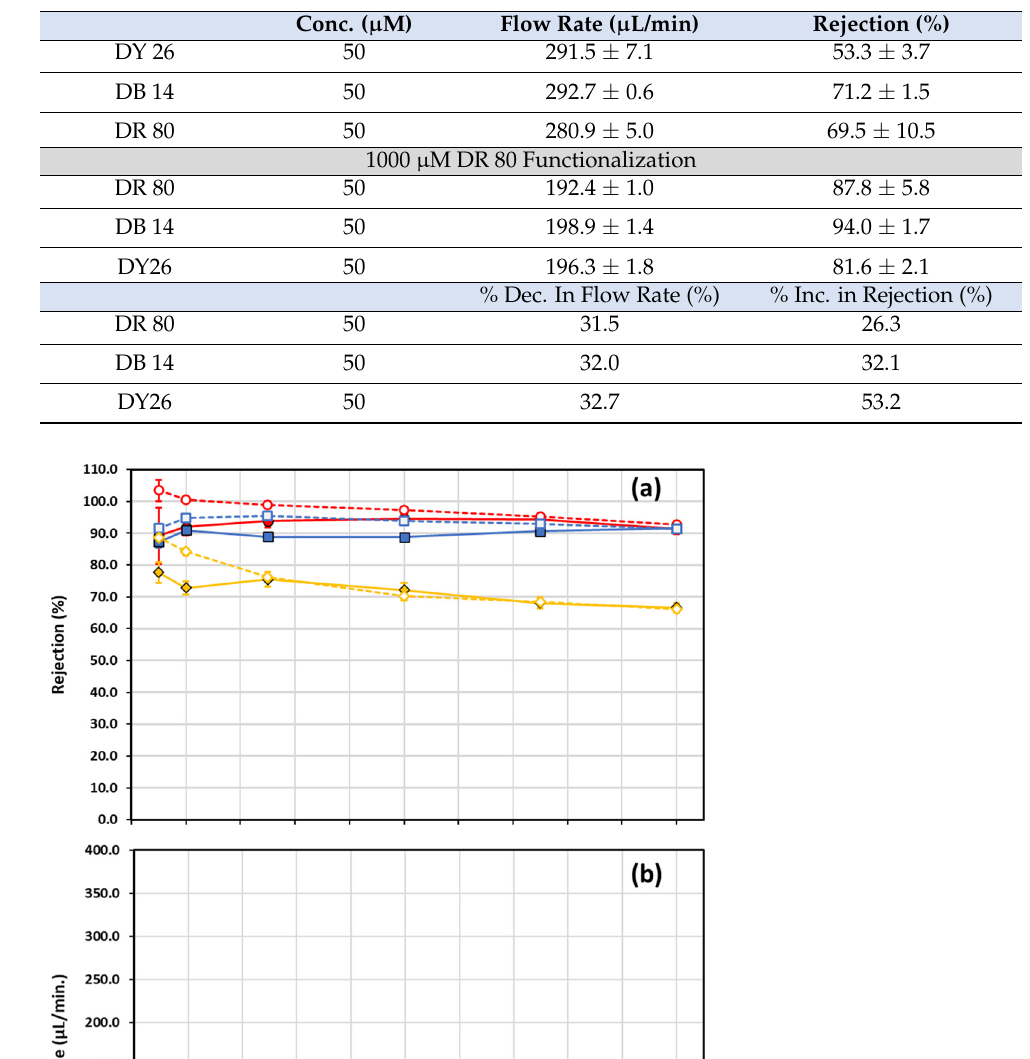
Table 1. Rejection and flow rate values for 50 µ M concentrations of direct yellow 26, direct blue 14, and direct red 80 pre- and post-azo-dye-functionalization on an unmodified polycarbonate filter with direct red 80 at 1000 µ M for 35 min.